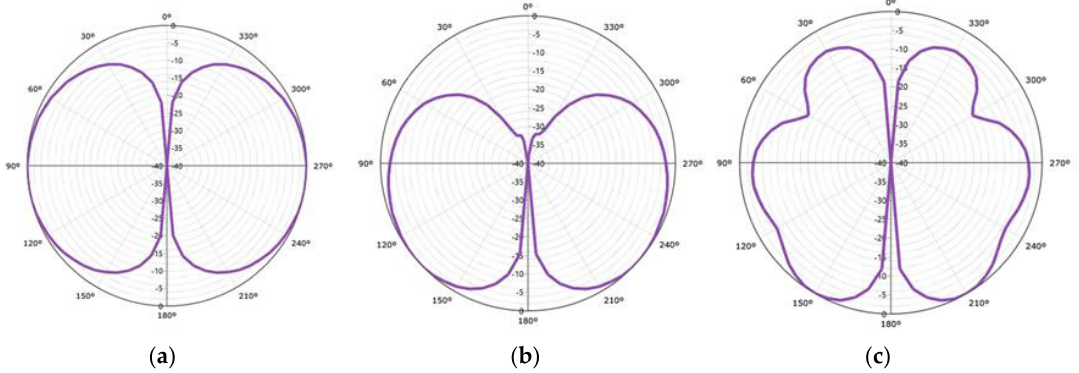
Figure 3. Radiation patterns (vertical plane) of the discone antenna at (a) minimum operation frequency (left), (b) center operation frequency (center), (c) maximum operation frequency (right).